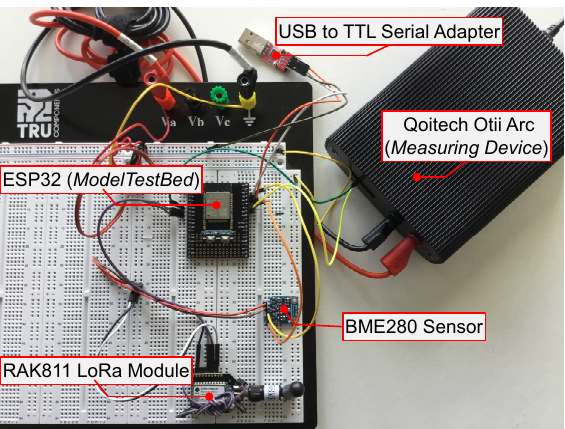
Figure 20. Basic layout of the ModelTestBed connected to the Qoitech Otii Arc measurement unit. The Qoitech Otii Arc measurement was flashed with firmware version 1.1.6 and